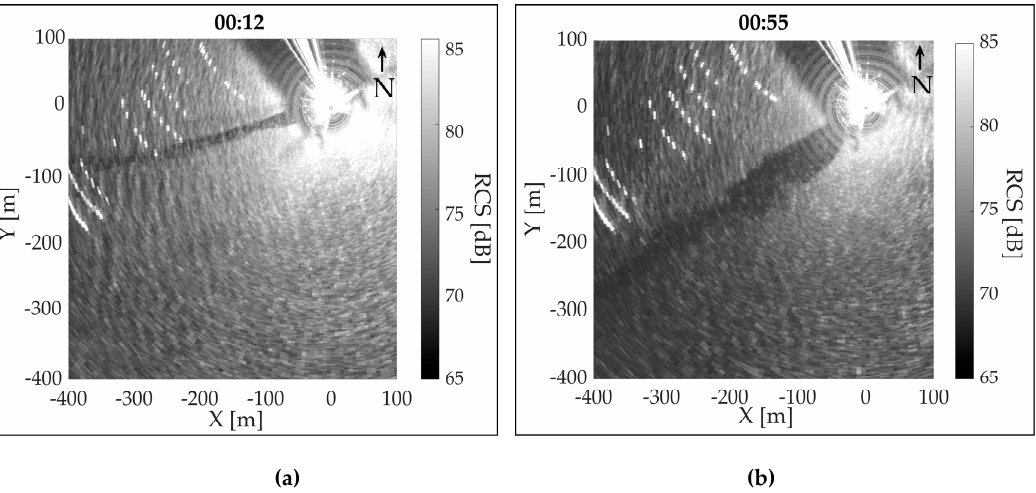
Figure 11. Examples of radar snapshots of slick band at different surface velocities: ( a ) 0.42 m/s, ( b ) 0.23 m/s.